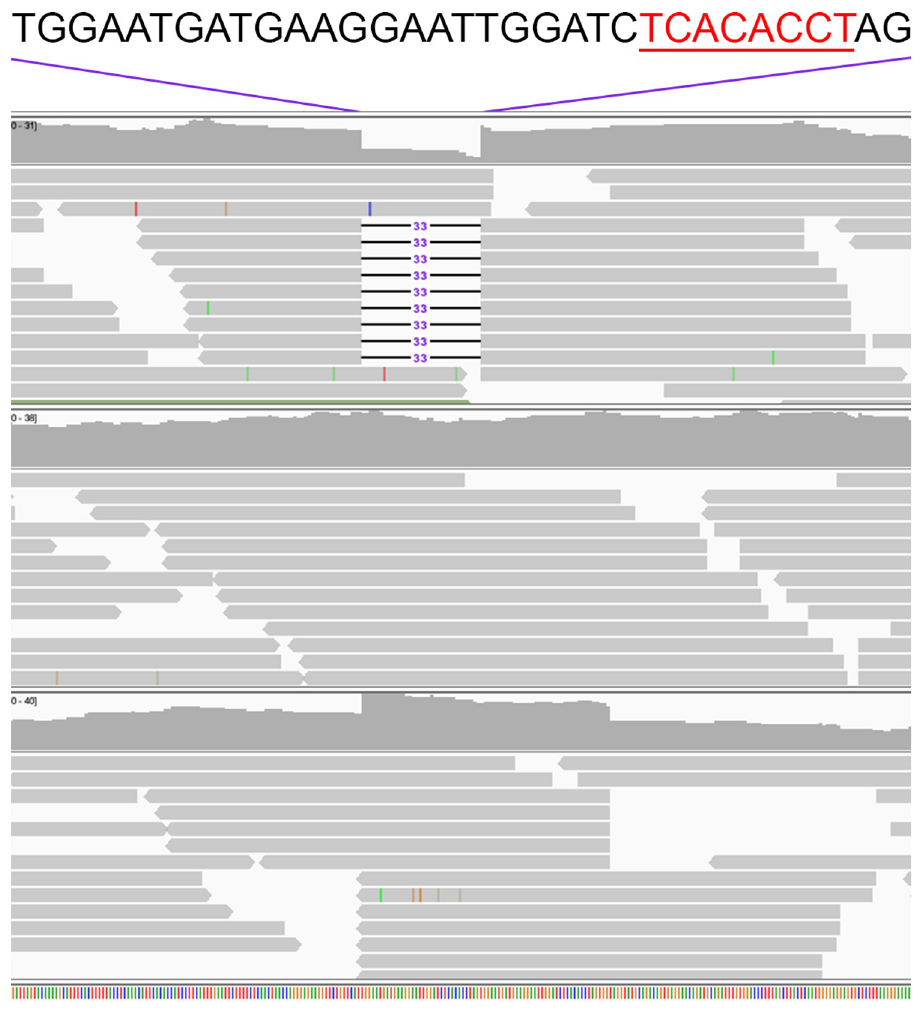
Fig 5. VNTR sequence and genotyping. Sequence of the 33 bp VNTR is shown, with the 8 bp T-box protein consensus sequence in underlined red text. IGV screenshot displays homozygosity for alleles 1 (top), 2 (middle; reference allele), and 3 (bottom) of the